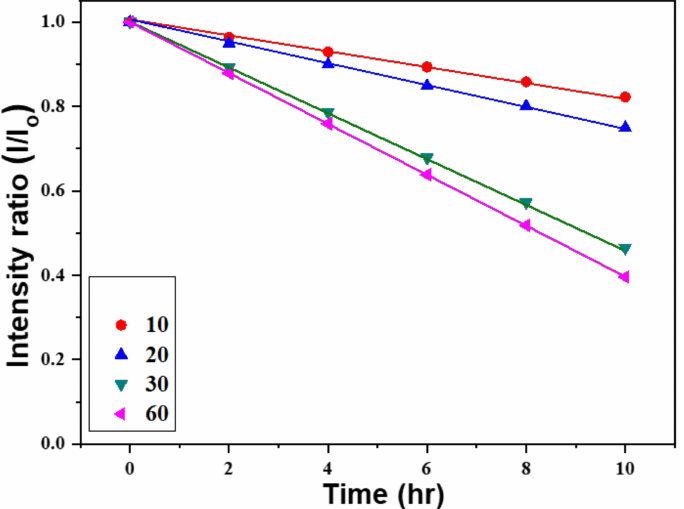
Figure 10. Variations of absorption intensities for methylene blue solutions under different irradiation time of UV light and synthesis time of ZnO